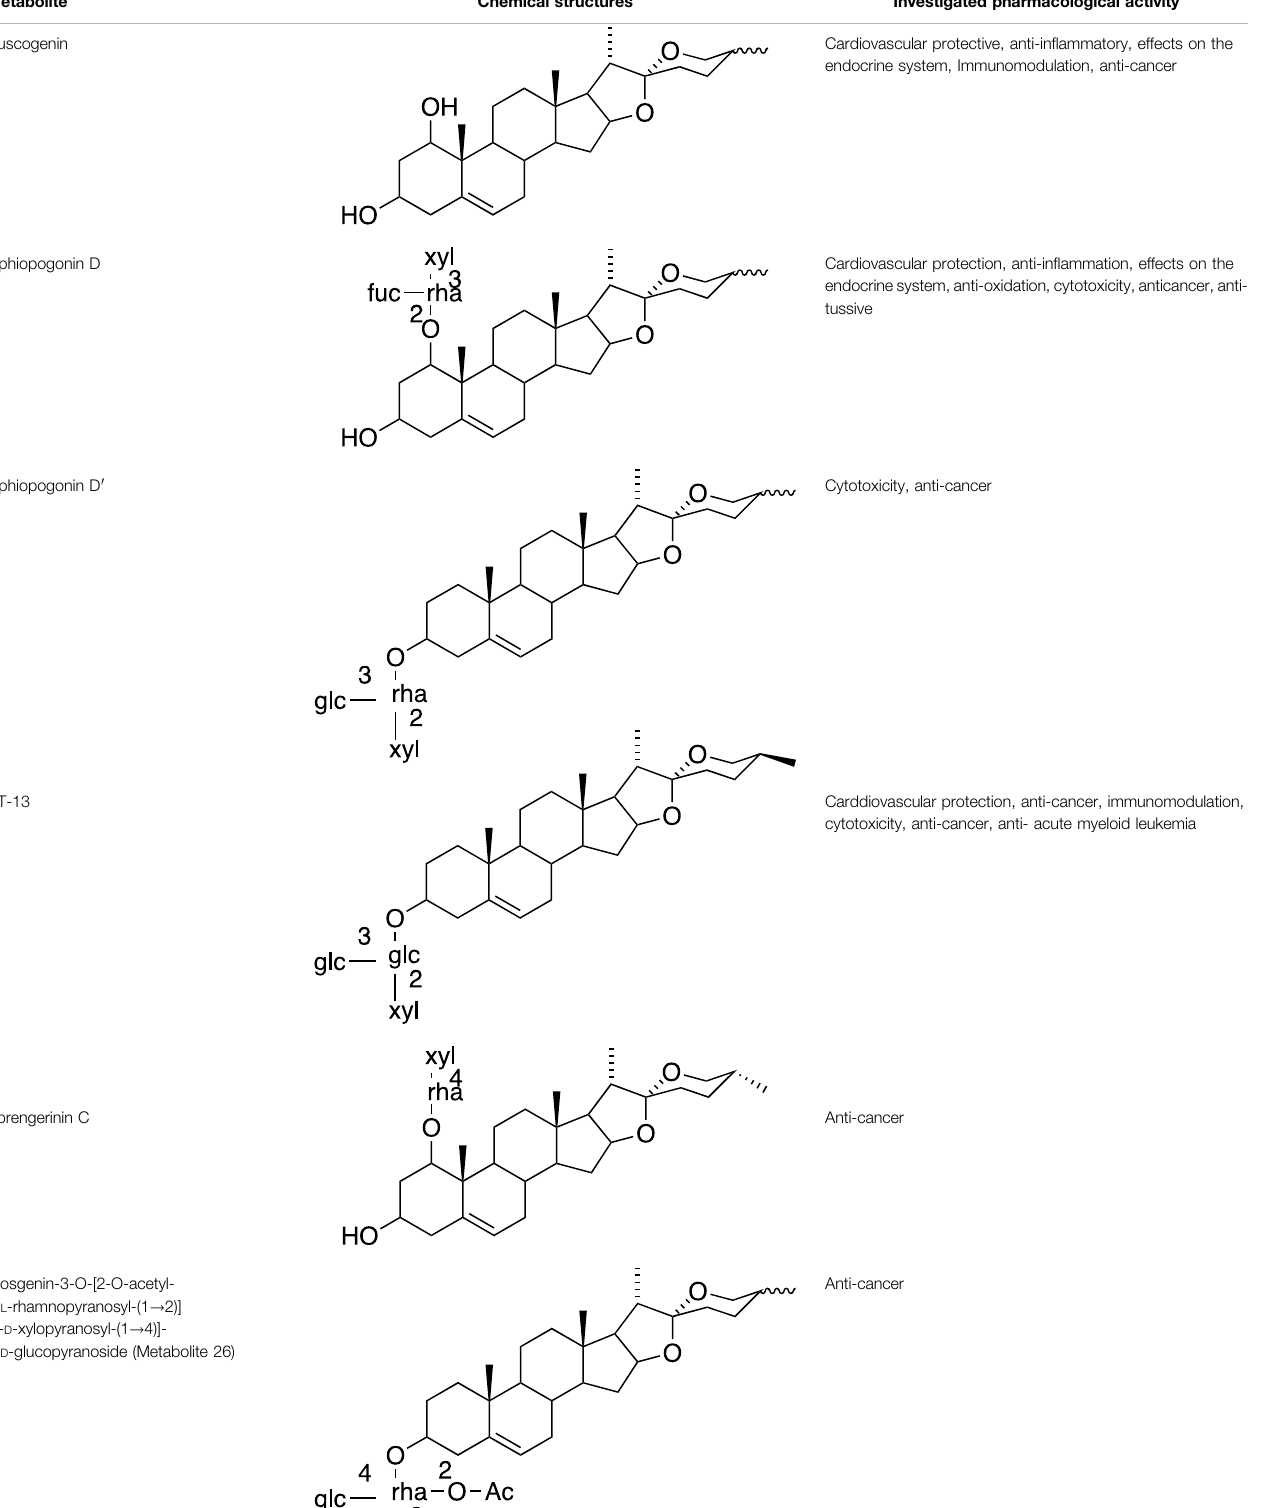
TABLE 2 | Chemical structures of pharmacologically investigated metabolites with corresponding activities of liriopogons (details of activities can be found in Table 3 ).